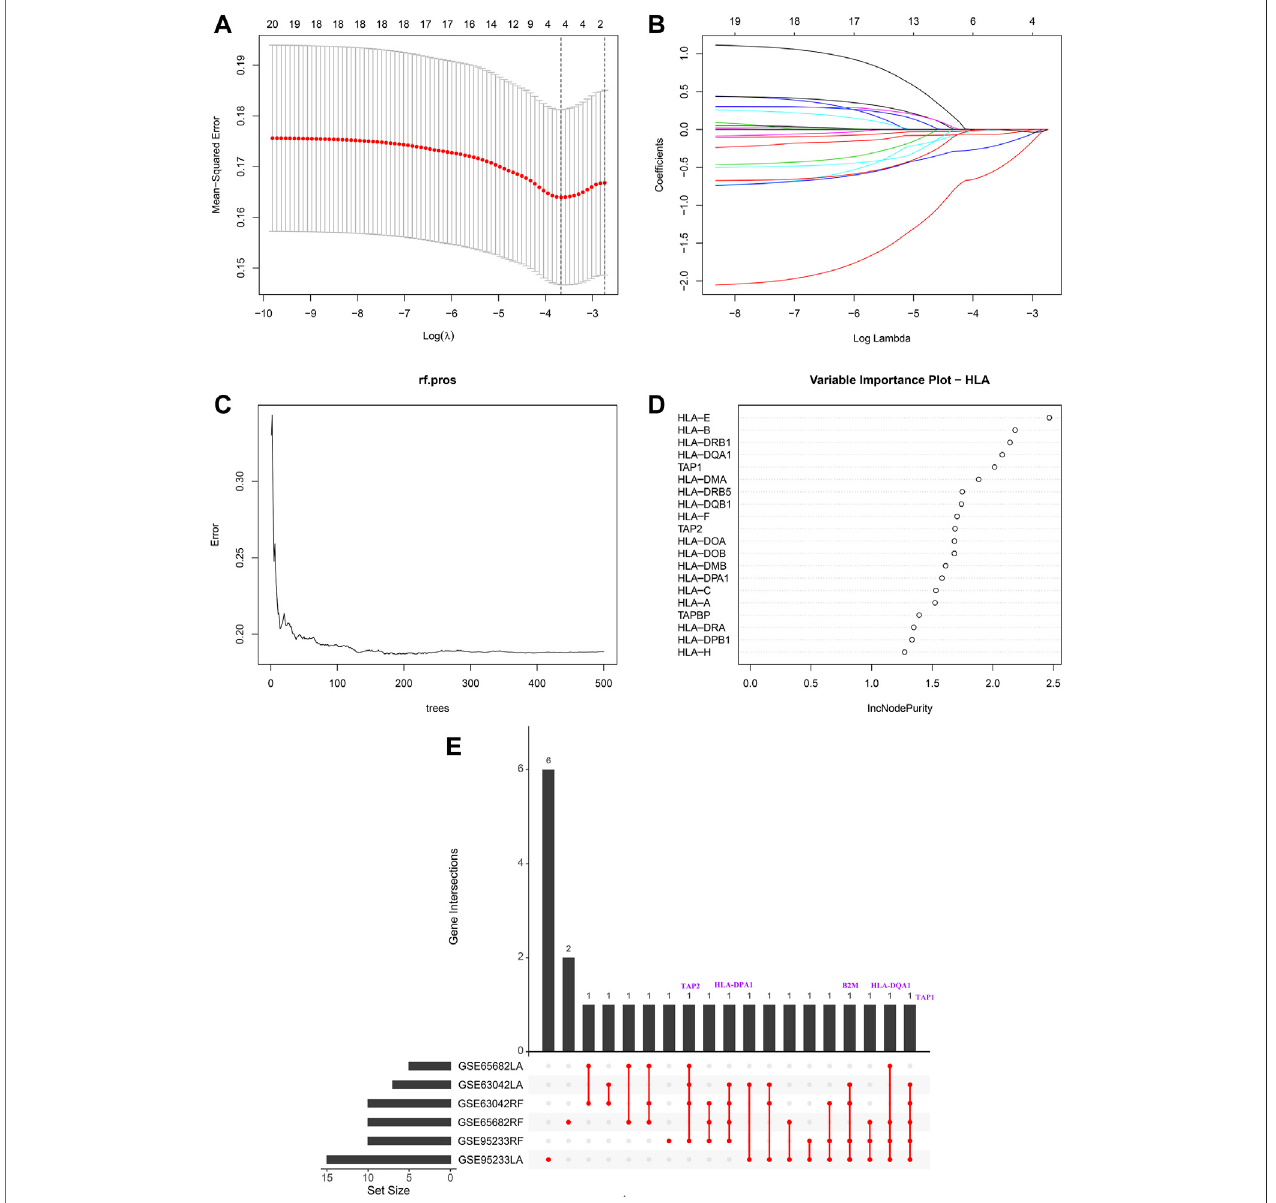
FIGURE1| HubHLAgenesselectedbyLassoregressionanalysisandrandomforest(RF)inGSE65682datasets. (A) Thetwodottedverticallinesaredrawnatthe optimal values by minimum criteria (left) and 1 — s.e. criteria (right). (B) Lasso coef fi cient pro fi les of the four hub HLA genes. A vertical lineis drawn at the optimal value by minimum criteria and results in four non-zero coef fi cients. (C) Distribution diagram of regression tree and error. (D) Important variables ranked by IncNodePurity. (E) UpSet plot presents the intersection of six results to identify hub HLA genes.